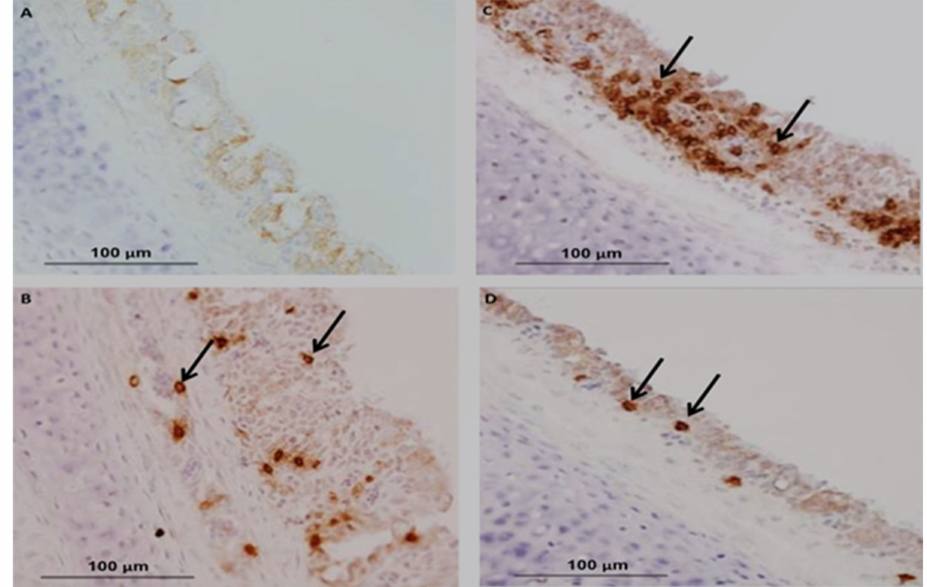
Figure 5. Immunohistochemically found in Tracheal mucosa as control ( A ), CD4+ cells ( B ), CD8+ cells ( C ) and IgA-bearing B cells in ( D ) at day 28 of age. Chickens vaccinated with live H120 or combination with CR88 at day 1 and subsequently with booster vaccinations. Arrows specify the positive immune cells (Magnification × 400) (Reprinted with permission from ref. [44]. Copyright 2021 American Society for